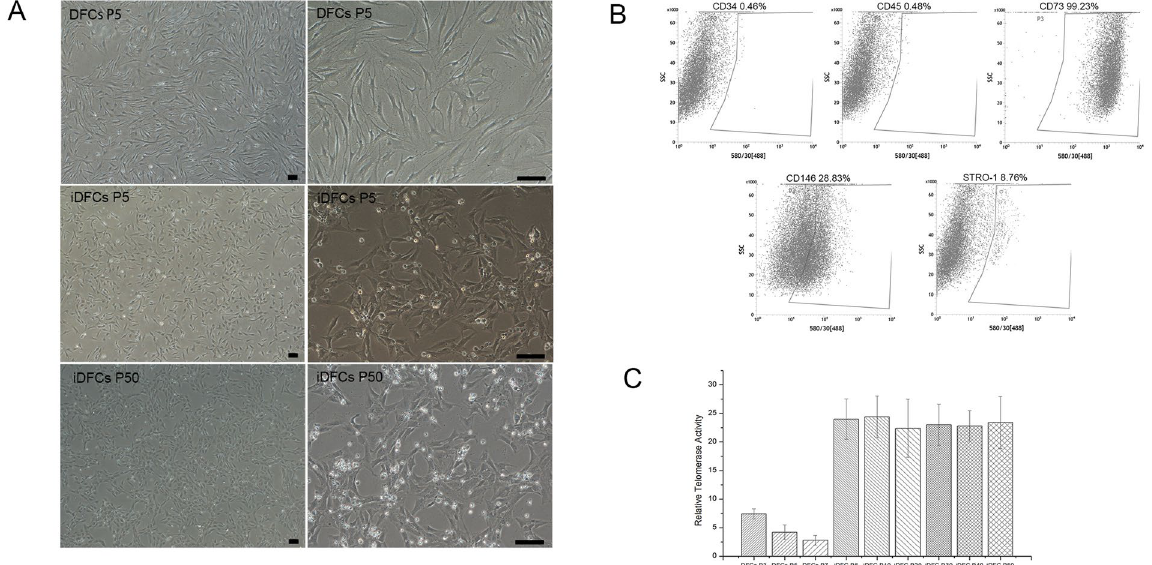
Figure 1. Morphology, phenotype and telomerase activity of immortalized DFCs. ( A ) The morphology of DFCs at passage 5 and iDFCs at passage 5, 50. Bar: 10 μ m; ( B ) The phenotype of iDFCs; ( C ) The telomerase activity of DFCs and iDFCs at various passage. The telomerase activity of cells significantly increased after